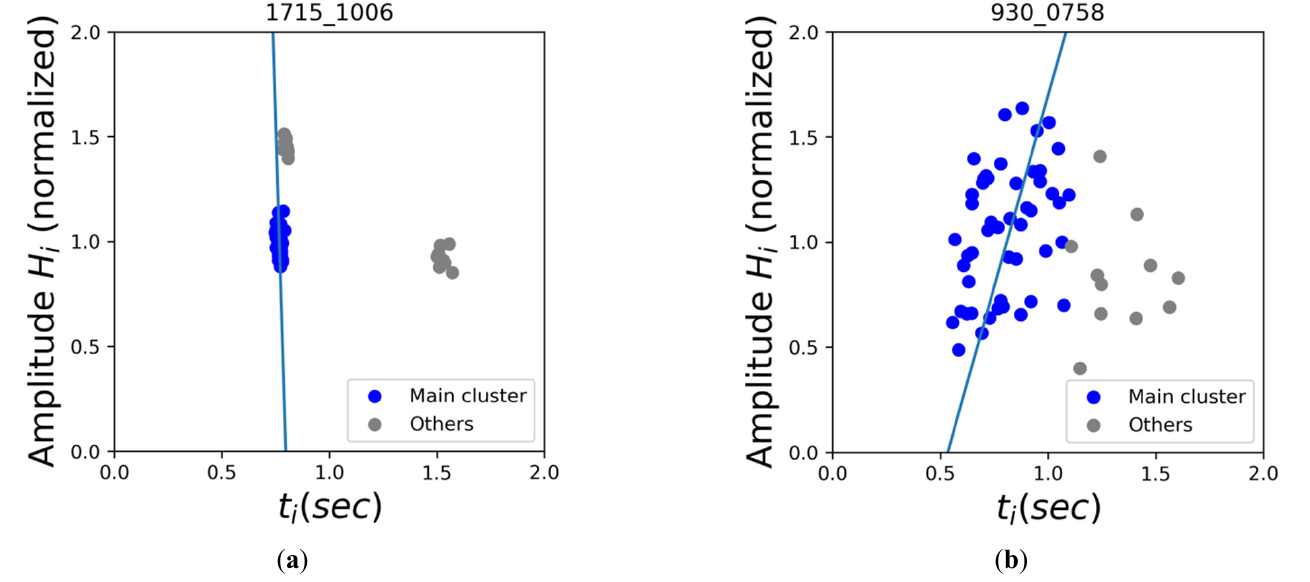
Figure 4. Examples of orthogonal regression line on the main cluster of ( a ) PVC sample and ( b ) AFib sample.